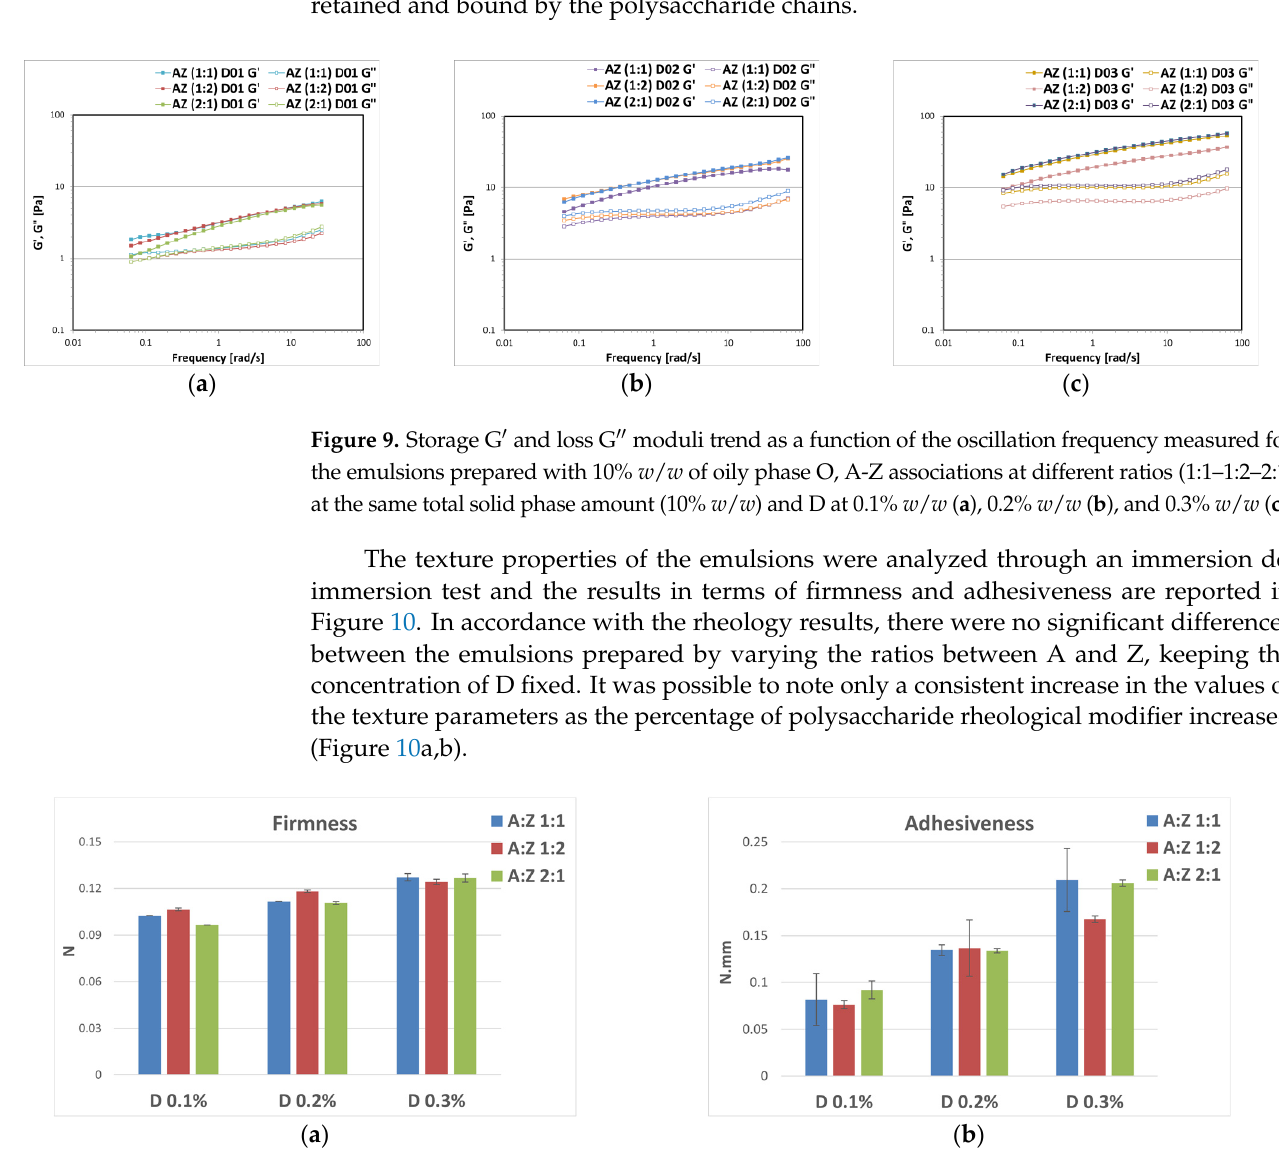
Table 6. Stability test results of emulsions formulated with Zea mays starch A and zinc oxide Z (total solid phase at 10% w/w), diutan gum D at 0.1% w/w, and different oil phases O at 10% w/w. Sample Name